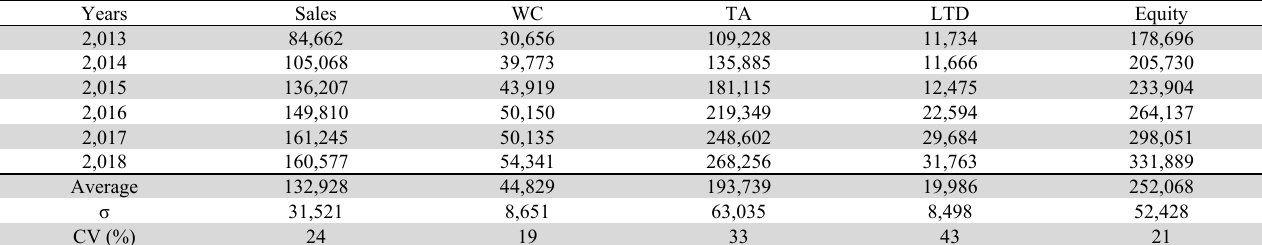
Variability of absolute average amounts of size determinants (Sales, WC, and TA), and LTD & Equity ( Rs. in Million) of Indian pharmaceutical